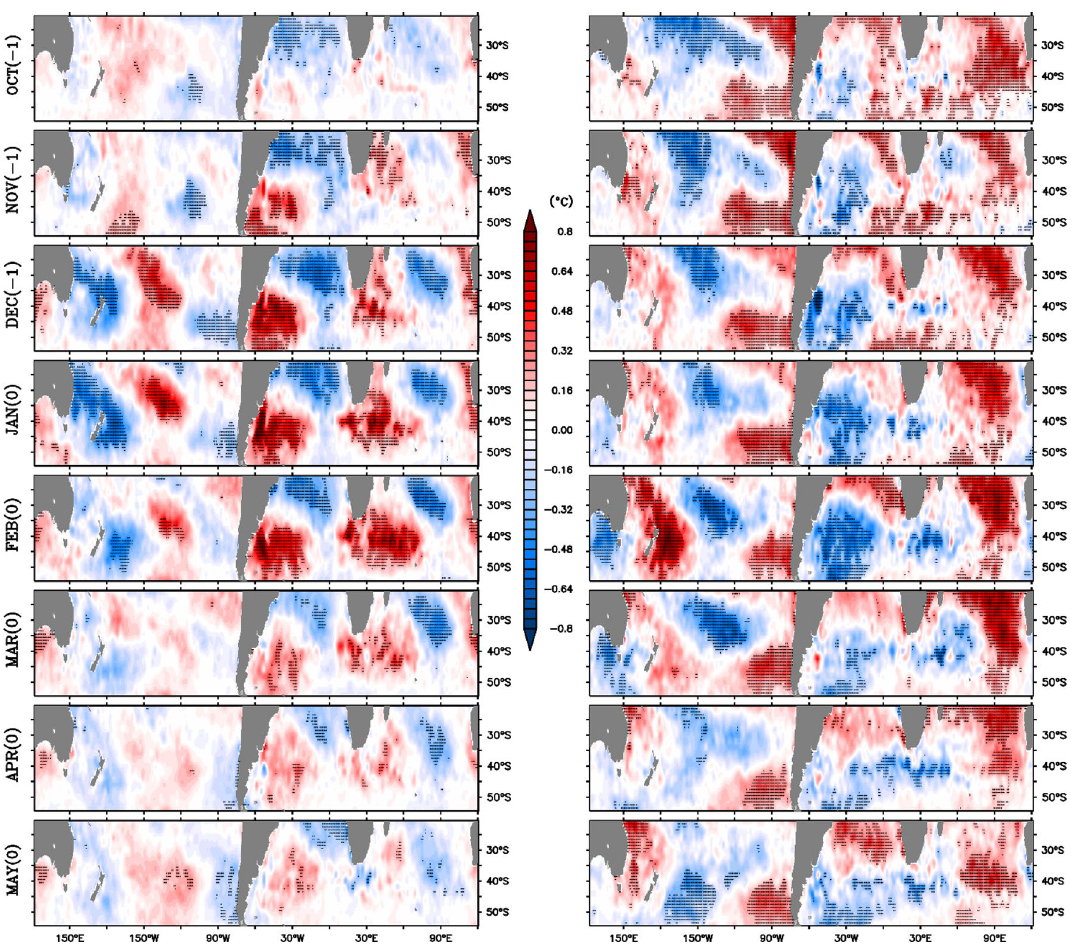
Figure 4. Left (right) panels show the monthly composite maps of positive (negative) W4 years from October (− 1) to May (0) in SST anomaly (in °C). (− 1) suggests the preceding year of the event year (0). Hatched areas represent the values satisfying 95% confidence with a two-tailed t-test. In this analysis HadISST data are